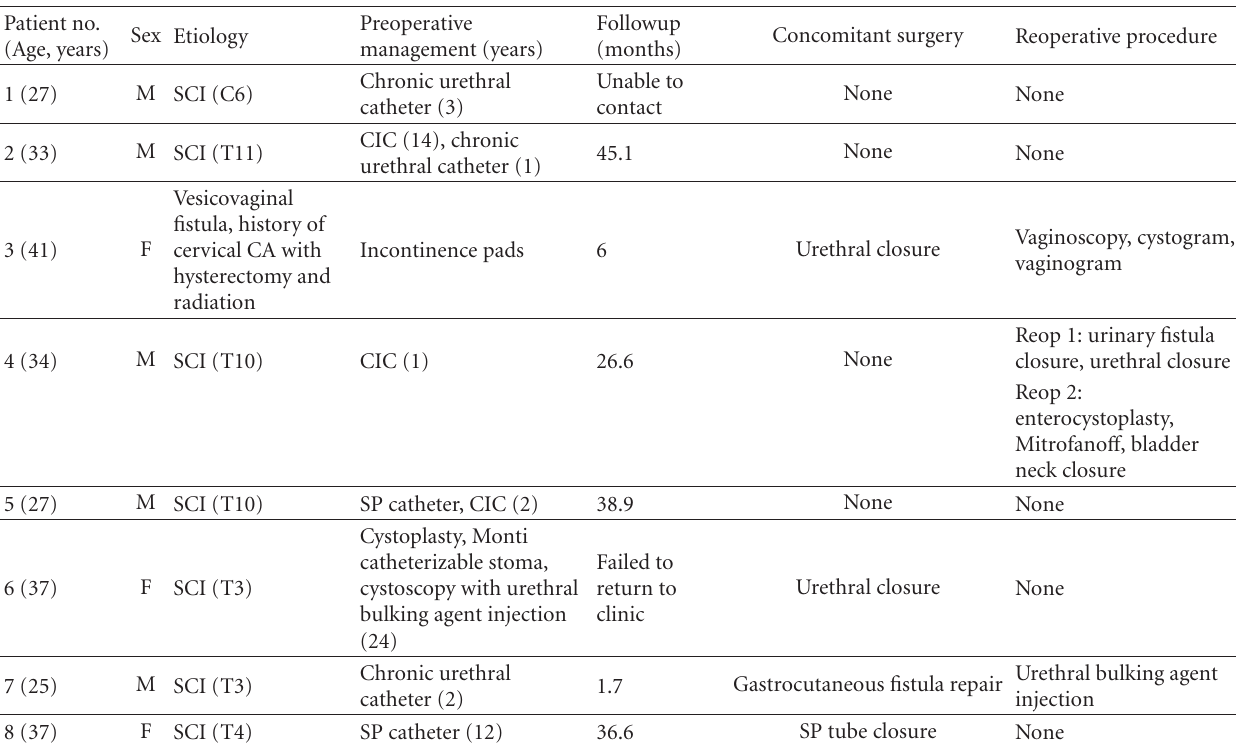
Figure 1: Decision tree for the management of neurogenic bladder. Table 2: Patient